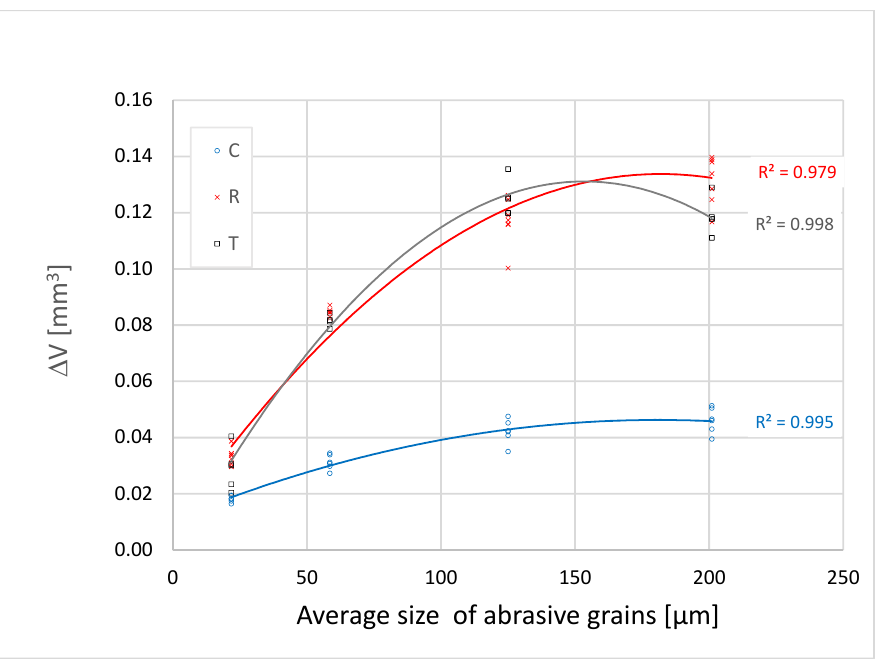
Figure 6. Dependence of the abrasion volume loss in Sample 2 on the average size of abrasive grains.